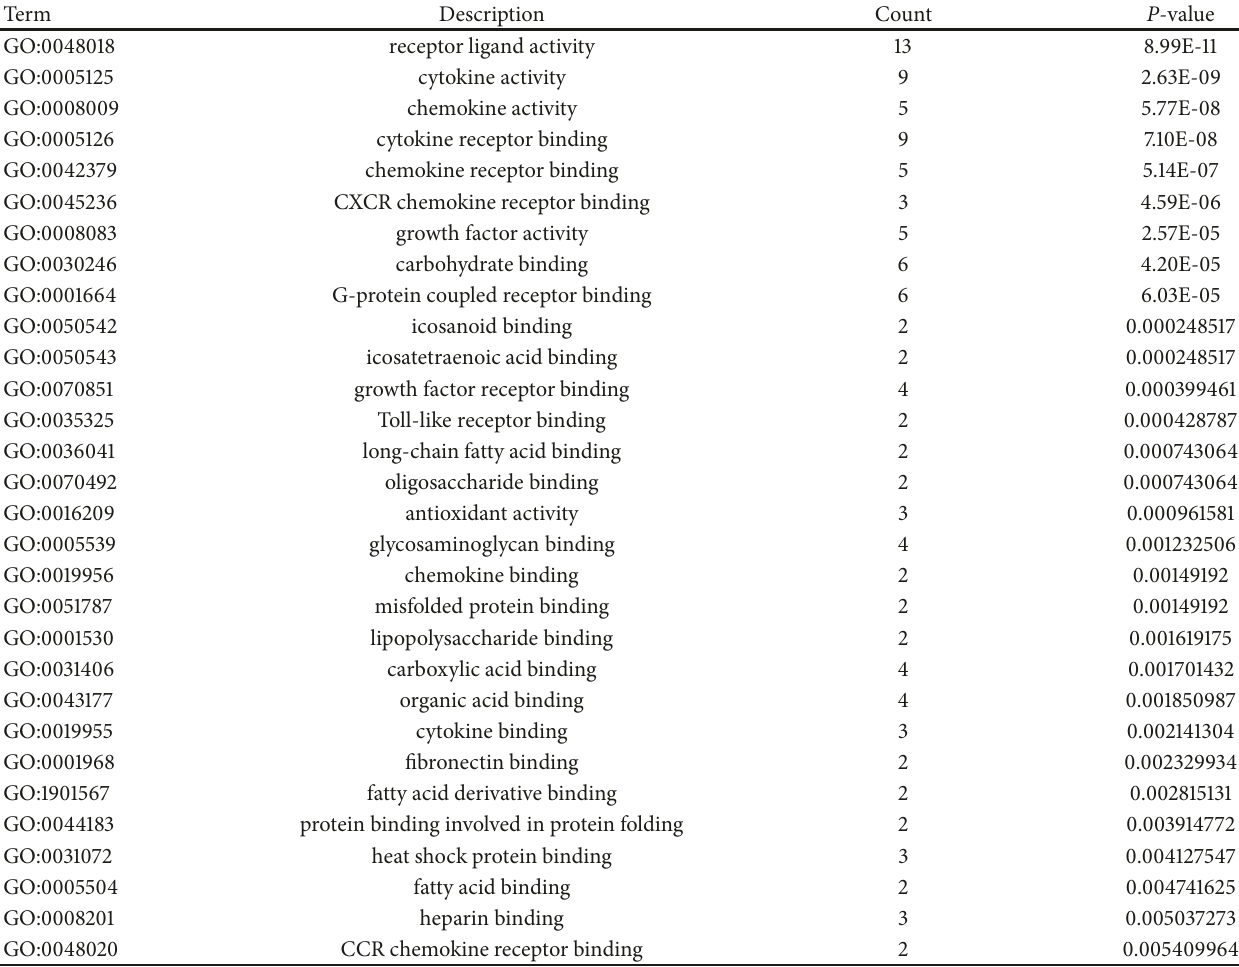
Table 3: GO analysis of genes associated with